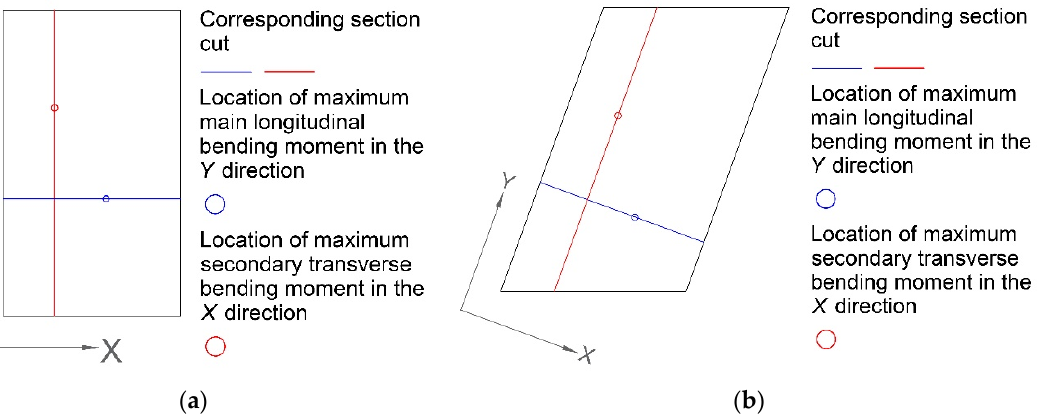
Figure 5. Principle of the effective width applied to moment determination [41].